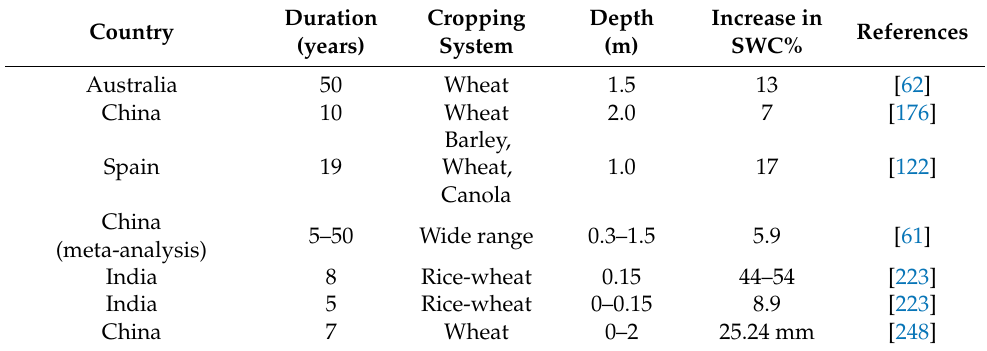
Table 4. Examples of the change in soil water content following the adoption of conservation agricultural practices (zero or minimum tillage + crop residue retention, with or without crop